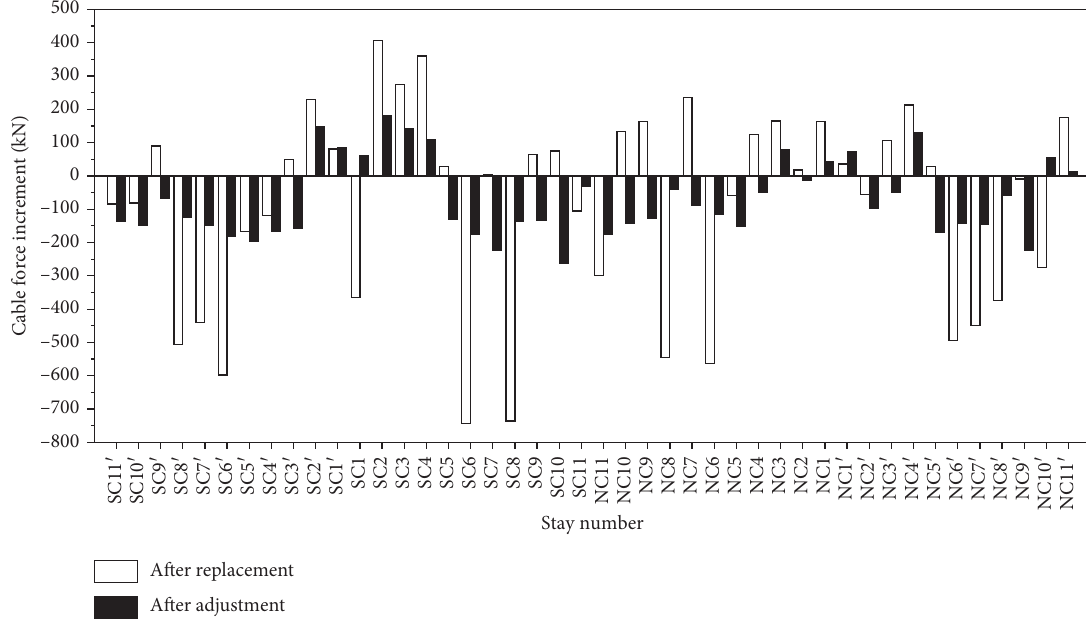
Figure 15: Cable force increments after cable replacement and